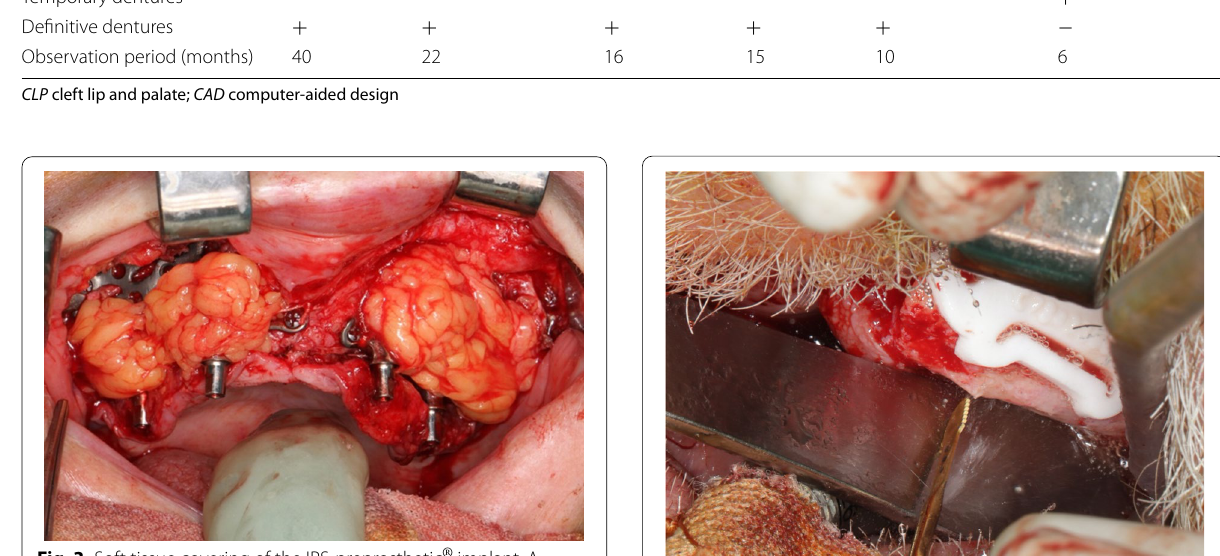
Fig. 3 Soft tissue covering of the IPS‑preprosthetic ® implant. A Bichat´s fat pad flap is used for covering the buccal framework as a submucosal second layer